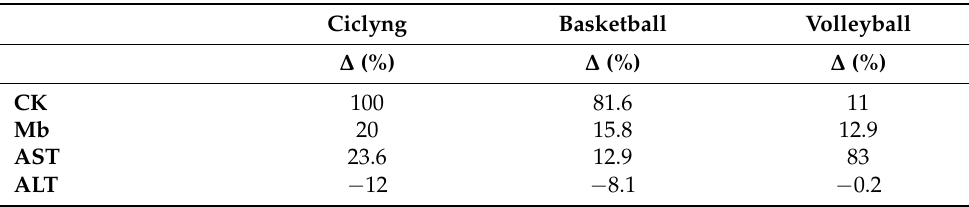
Table 4. Differences in muscular damage blood markers comparing T1 vs. T2 in cyclists, basketball and volleyball players. Ciclyng Basketball Volleyball ∆ (%) ∆ (%) ∆ (%)